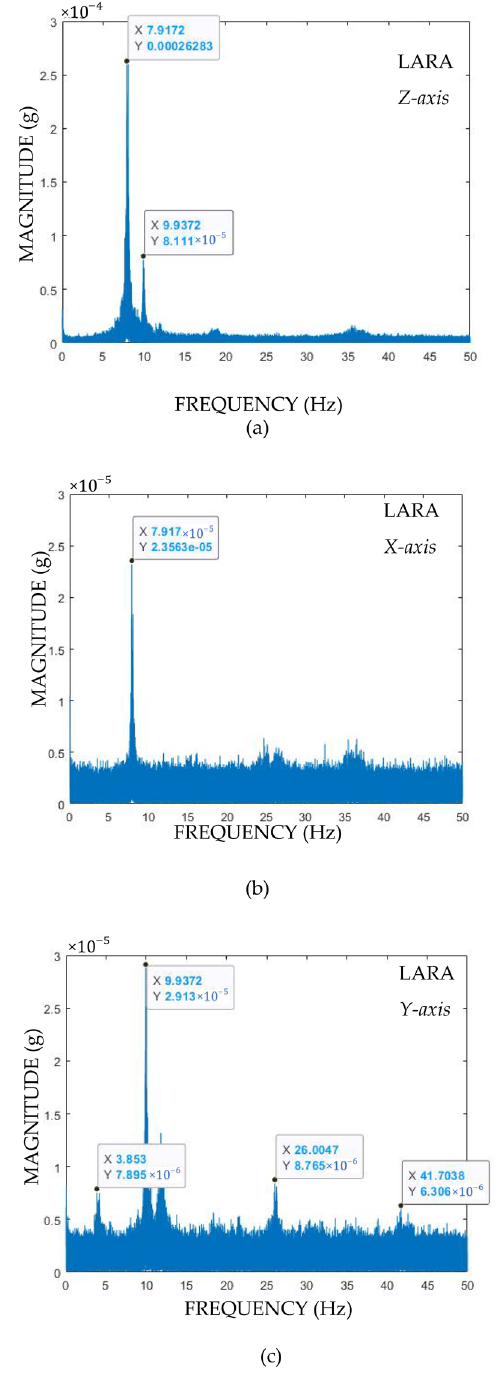
Figure 12. Eigenfrequency analysis of a footbridge using LARA for ( a ) vertical, ( b ) longitudinal, and ( c ) transversal directions of the footbridge.